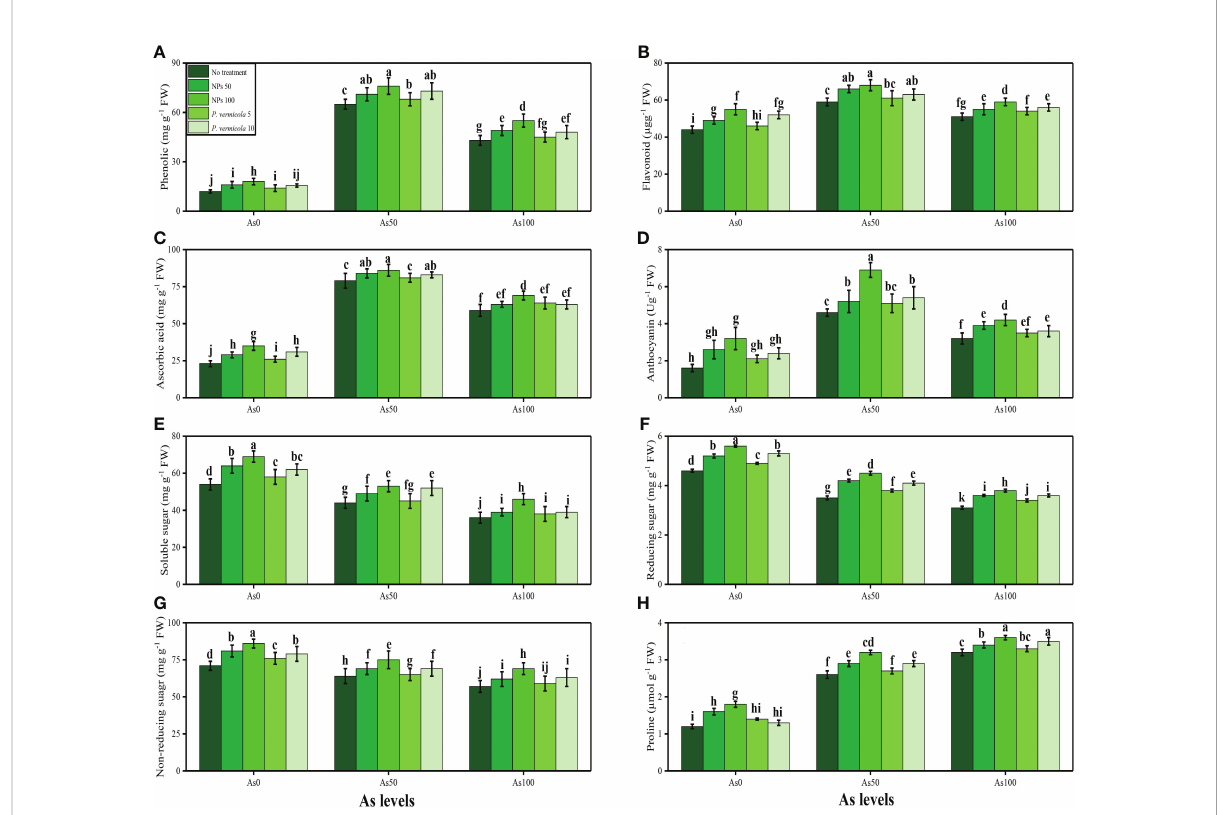
FIGURE 6 Effect of combined application of various levels of iron oxide nanoparticles (FeO-NPs) (i.e., 50 mg/l − 1 and 100 mg/l − 1 ) and plant growth- promoting bacteria ( Providencia vermicola ) (i.e., 5 ppm and 10 ppm) on phenolic contents (A) , fl avonoid contents (B) , ascorbic acid contents (C) , anthocyanin contents (D) , soluble sugar contents (E) , reducing sugar contents (F) , non-reducing sugar contents (G) , and proline contents (H) of Ajwain ( Trachyspermum ammi seedlings) grown under various stress levels of arsenic (i.e., 0 m M, 50 m M, and 100 m M). Values are demonstrated as means of four replicates along with standard deviation (SD; n = 4). Two-way ANOVA was performed and means differences were tested by Tukey ’ s highly signi fi cant difference post-hoc test ( p < 0.05). Different lowercase letters on the error bars indicate signi fi cant difference between the